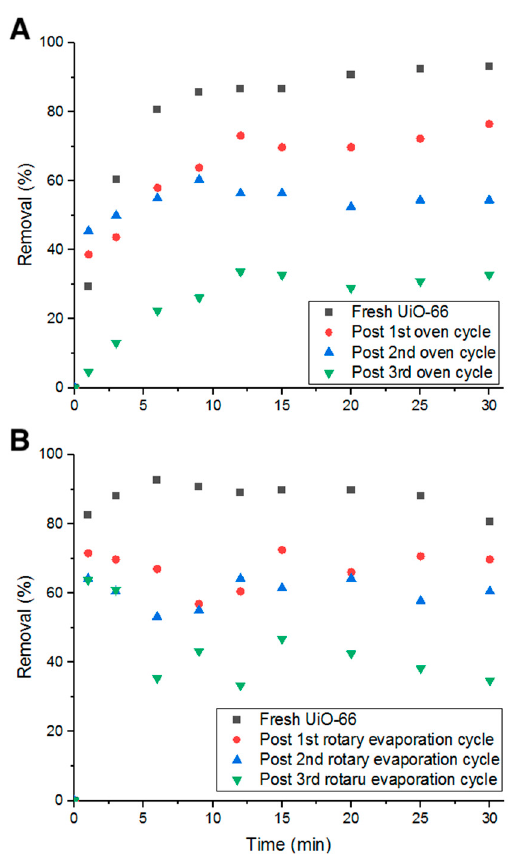
Figure 13. Percent removal with ( A ) oven heating cycles and ( B ) rotary evaporation cycles.